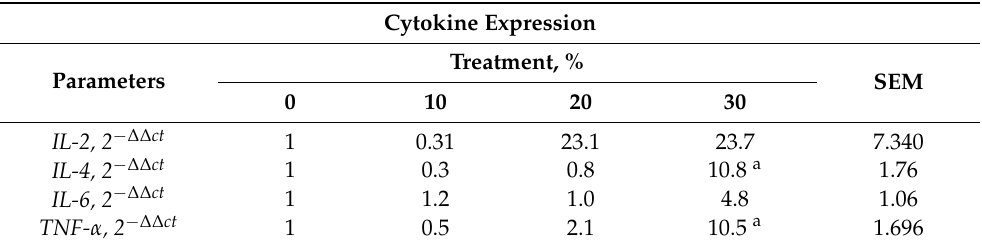
Table 8. Relative quantification values of the respective cytokines in growing meat goats supple- mented with varying levels of HSM on day 60 of feeding period.